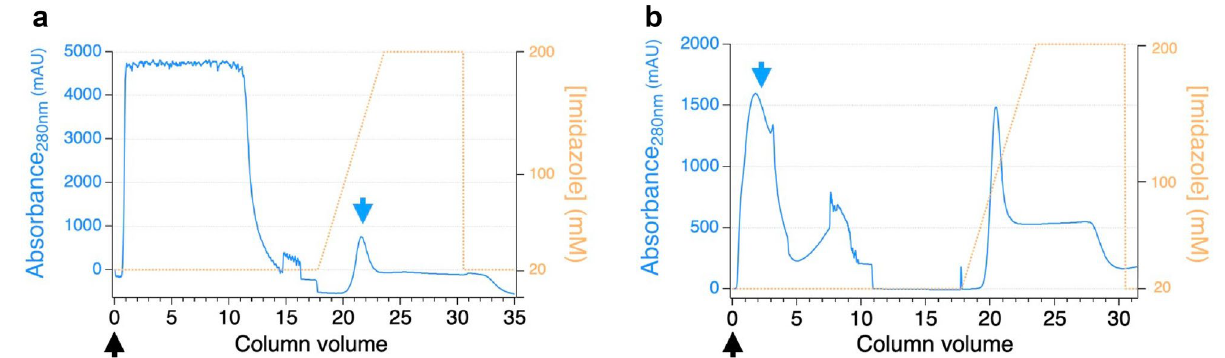
Figure 6. Elution profile of Thy1-scFv on Ni–NTA IMAC. ( a ) IMAC1: tagged-Thy1-scFv is collected during the elution step. ( b ) IMAC2: native Thy1-scFv is collected in the flow through fraction. Black arrows represent the time of injection, and blue arrows indicate the peak and elution time of the protein of